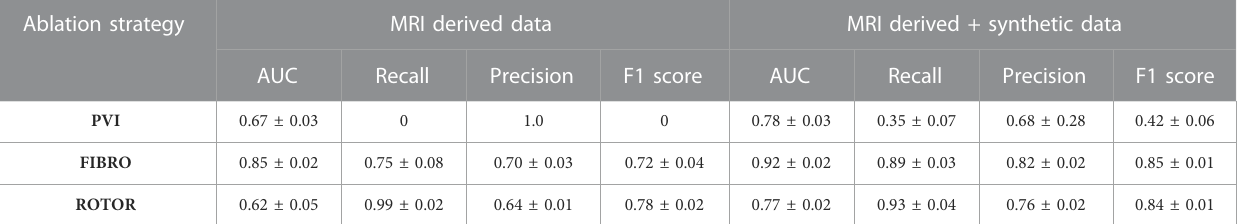
TABLE 4 Mean AUC, recall, precision and F1 score (with standard deviation) of DL model trained with real data only and with synthetic and real data from a leave- one-out cross-validation on a hold-out test (~20% of the respective dataset).